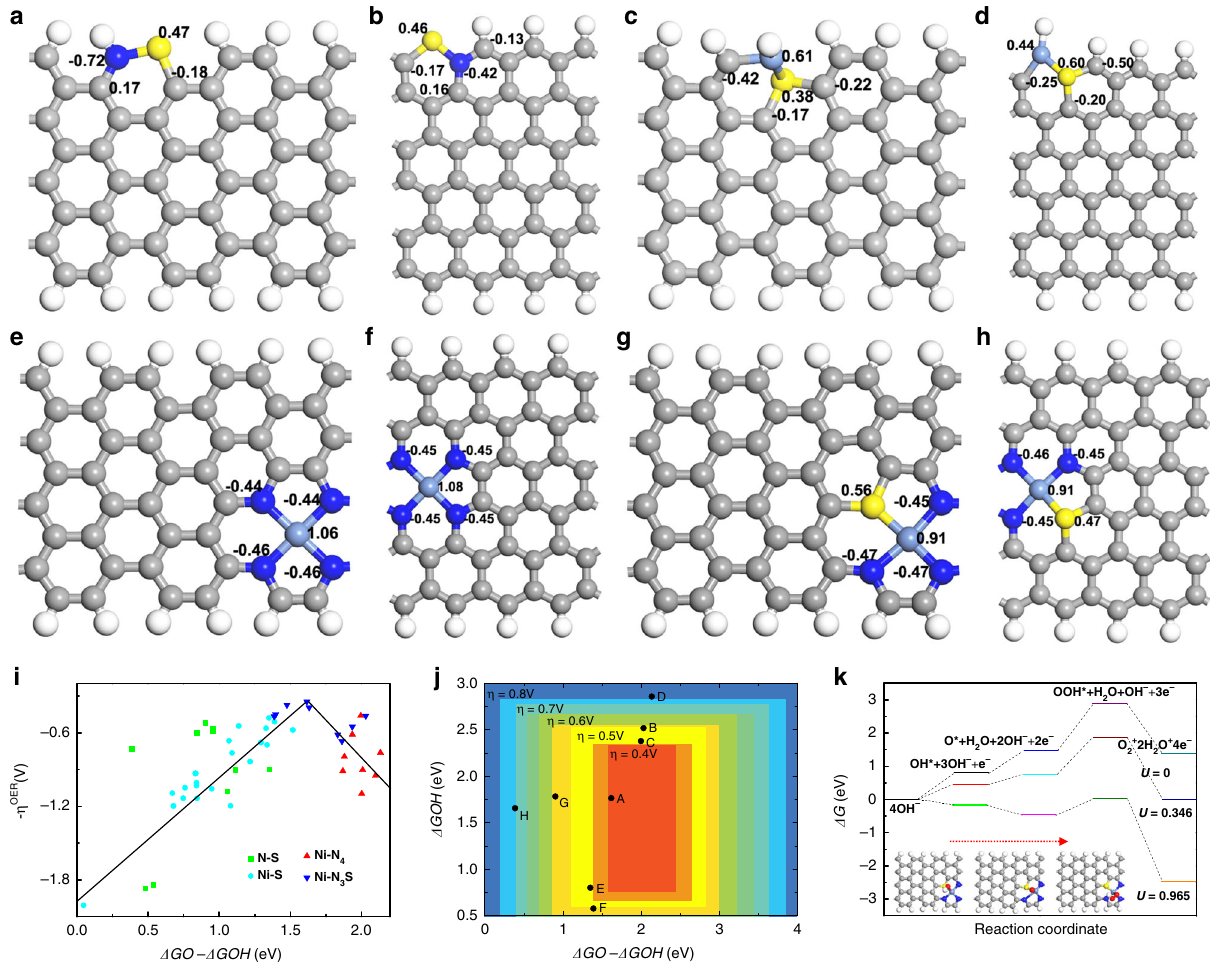
Fig. 4 Theoretical calculations. Population distributions for the DFT-calculated representative models: a N − S co-doped armchair nanoribbon, b N − S co- doped zigzag nanoribbon, c Ni − S co-doped armchair nanoribbon, d Ni − S co-doped zigzag nanoribbon, e Ni − N 4 -doped armchair nanoribbon, f Ni − N 4 - doped zigzag nanoribbon, g Ni − N 3 S-doped armchair nanoribbon, h Ni − N 3 S-doped zigzag nanoribbon. i OER volcano plot of the overpotential η vs. the difference between the adsorption free energy of O* and OH* for the N − S, Ni − S, Ni − N 4 , and Ni − N 3 S models. j Adsorption free energy of OH* vs. the difference between the adsorption free energy of O* and OH* for the N − S, Ni − S, Ni − N 4 , and Ni − N 3 S models. k Schematic free-energy pro fi le for the OER pathway on the Ni − N 3 S model in alkaline